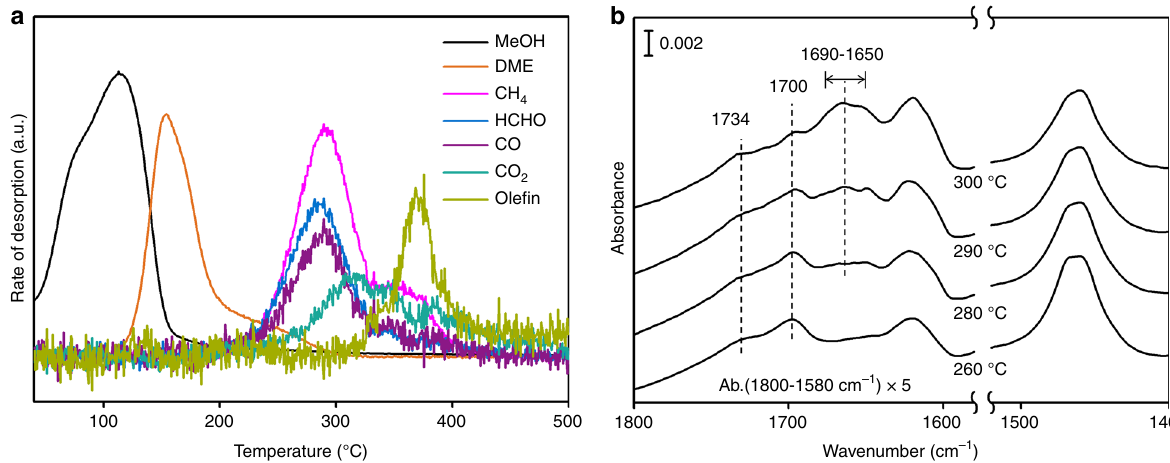
Fig. 2 Surface reaction of MeOH adsorbed on H-ZSM-5 with increasing temperature. a Desorbed products in gas phase; b IR spectrum of corresponding surface species on H-ZSM-5 taken in situ. Reaction conditions: H-ZSM-5 (Si/Al 15) 25 mg saturated under 3 mbar MeOH subsequently outgassed under vacuum, afterwards ramping temperature with 3 °C min − 1 under